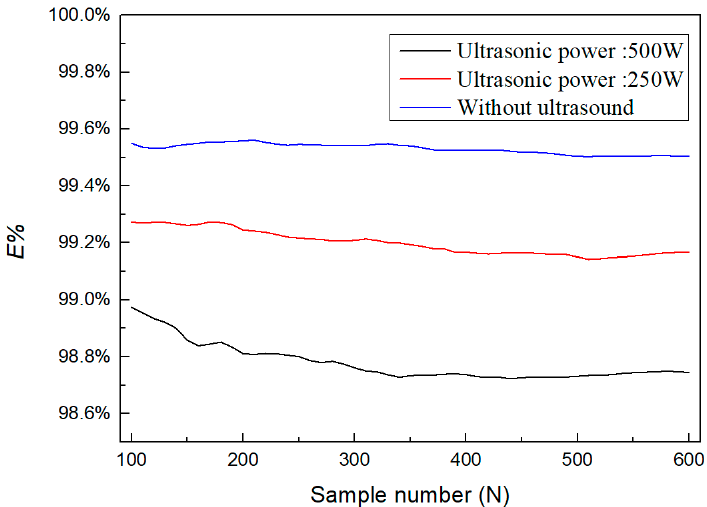
Figure 10. The total contribution, E %, of the first five modes.